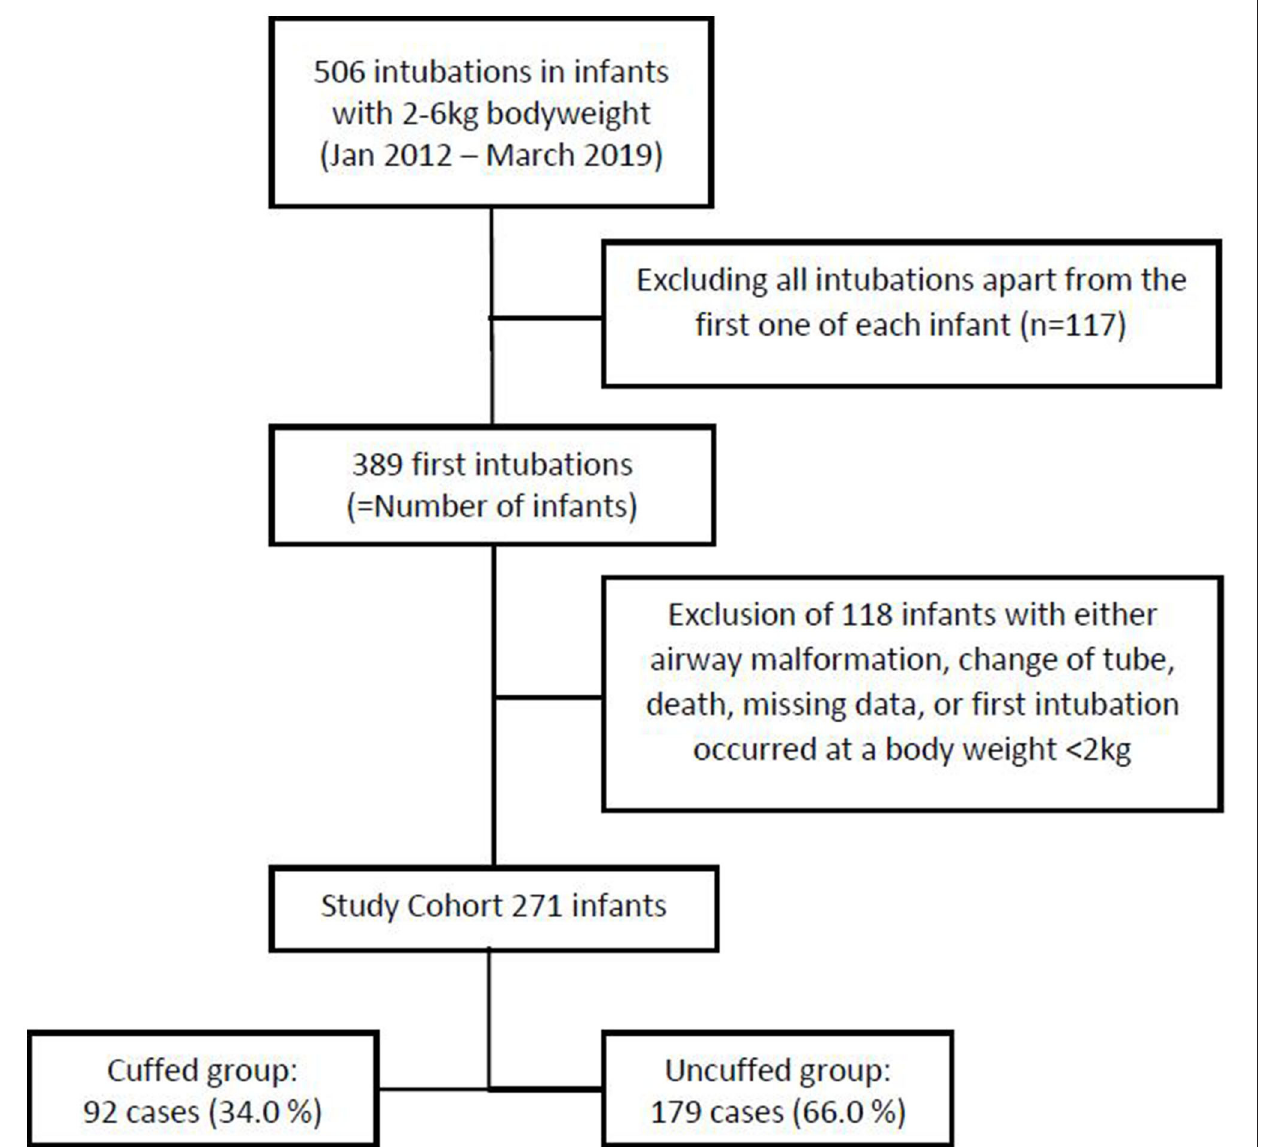
FIGURE 1 | Study cohort after applying exclusion